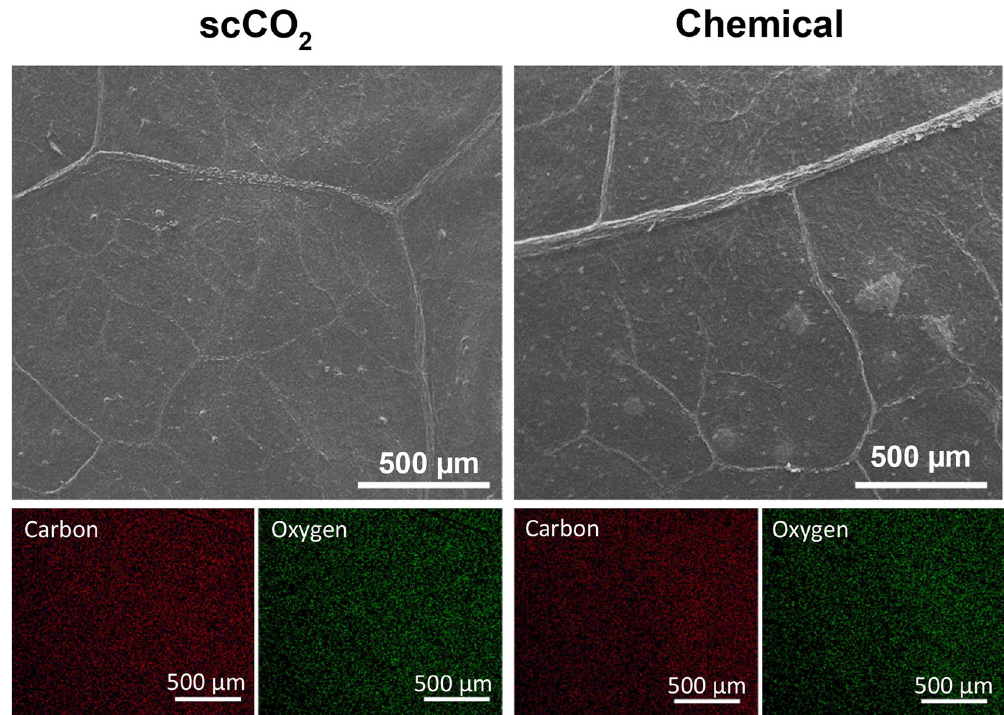
Figure 6. Elemental analysis mapping of scCO 2 and chemically decellularized scaffolds. SEM images (above) and corresponding elemental maps (below) for the most abundant elements, carbon (red) and oxygen